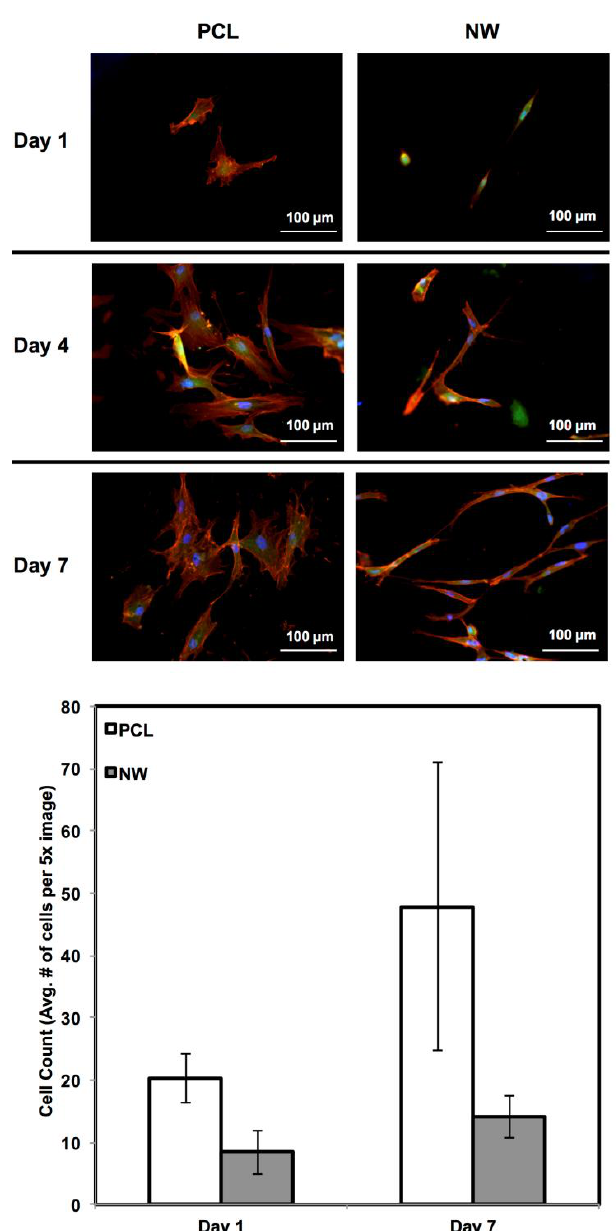
Figure 3. Representative fluorescence microscopy images of ADSCs on PCL and NW after 1, 4, and 7 days of culture; cell count after 1 and 7 days of culture. Cell nuclei were counted using DAPI fluorescence and ImageJ software